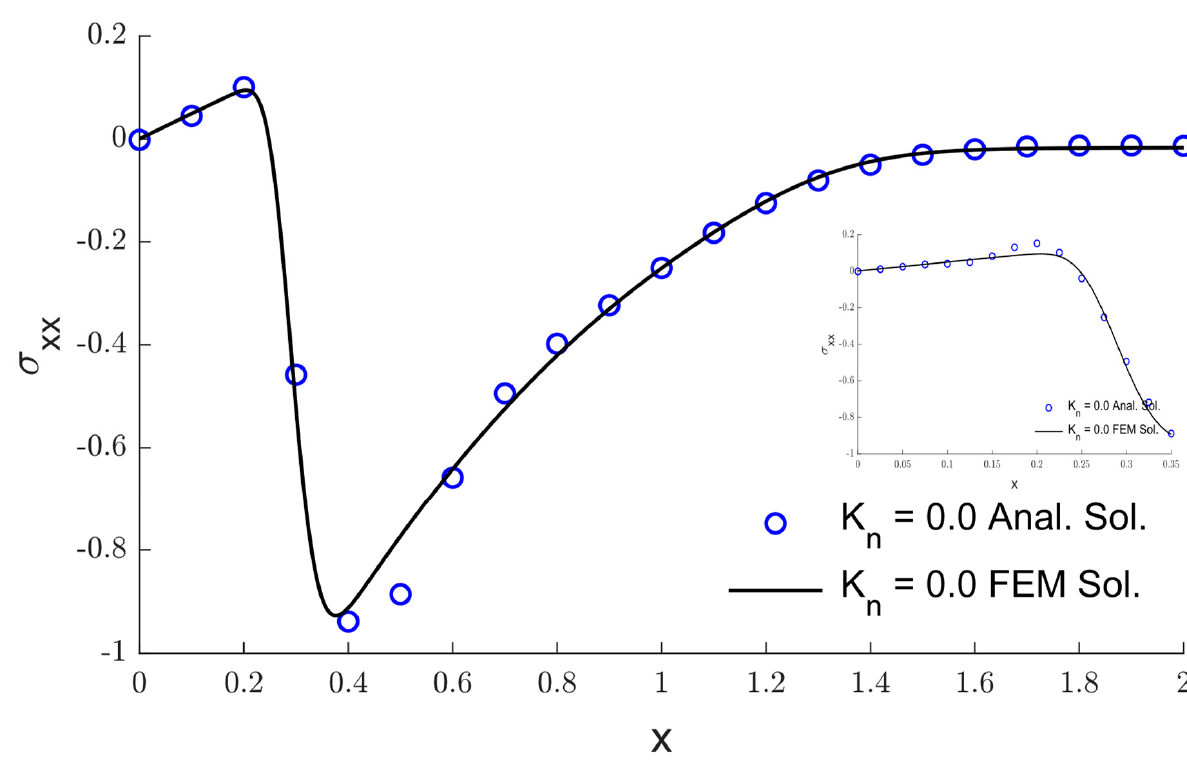
Figure 14. The stress comparison study when τ o = τ 1 = 0.05 and K n = 0.